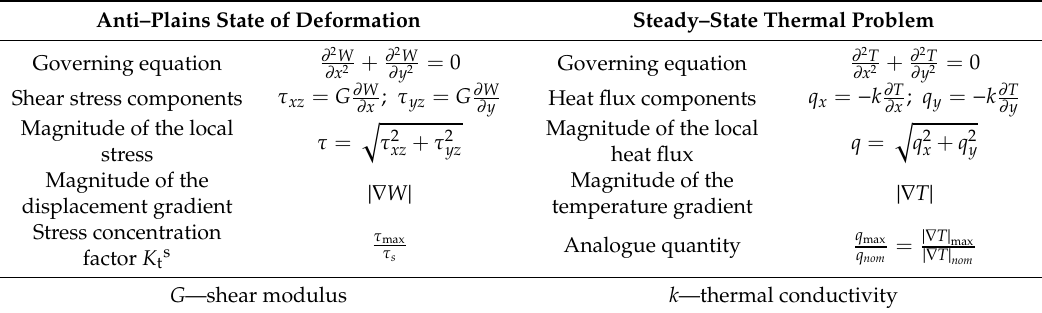
Table 2. Comparison of basic equations for anti-plane deformation and steady-state thermal problem. Anti–Plains State of Deformation